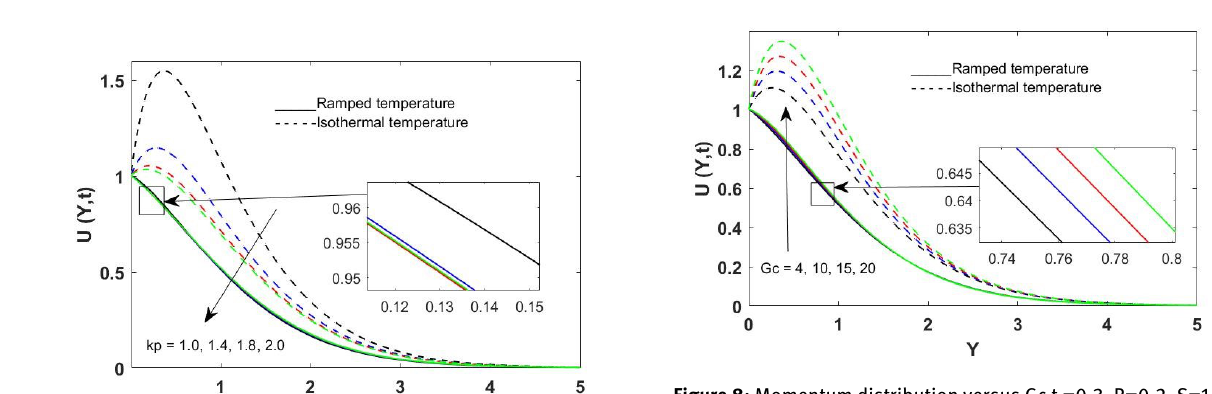
Figure 8: Momentum distribution versus Gc t =0.3, R=0.2, S=1, K=1,